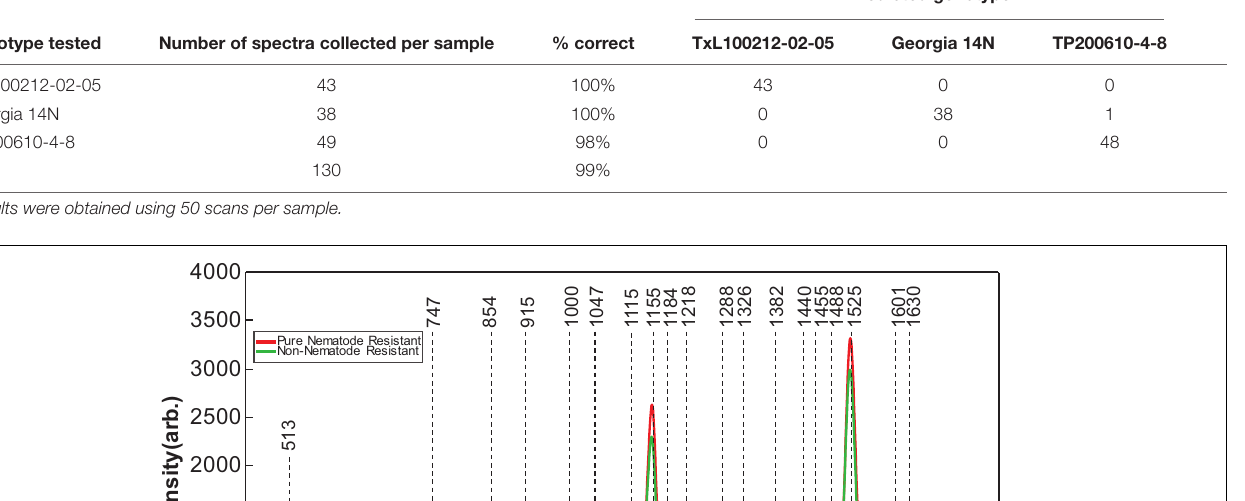
Predicted genotype